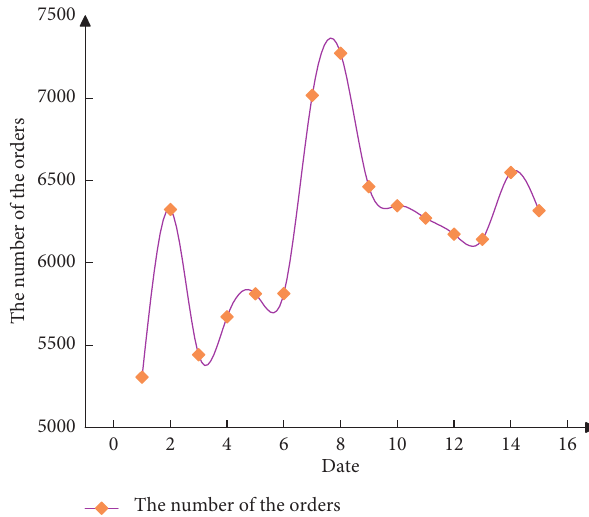
Figure 4: The average daily orders in the first half of January 2017 based on the historical